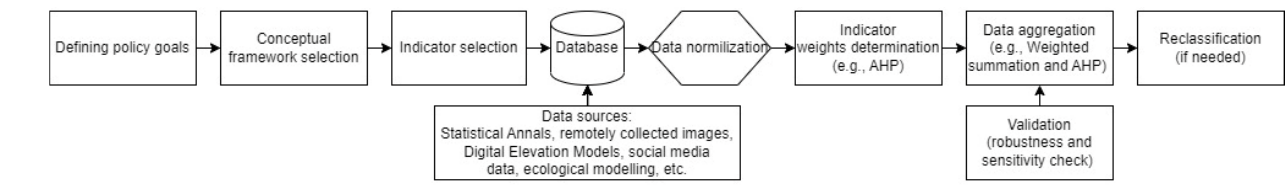
Figure 1. A general procedure of regional ecosystem condition assessment.